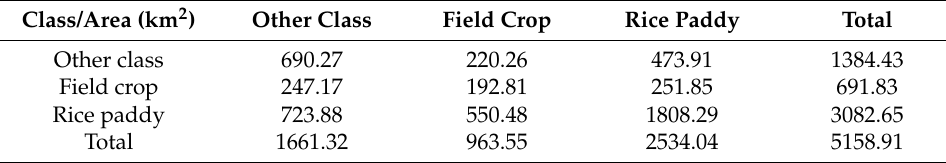
Table 11. Confusion matrix of the ODTW method in test site 2.